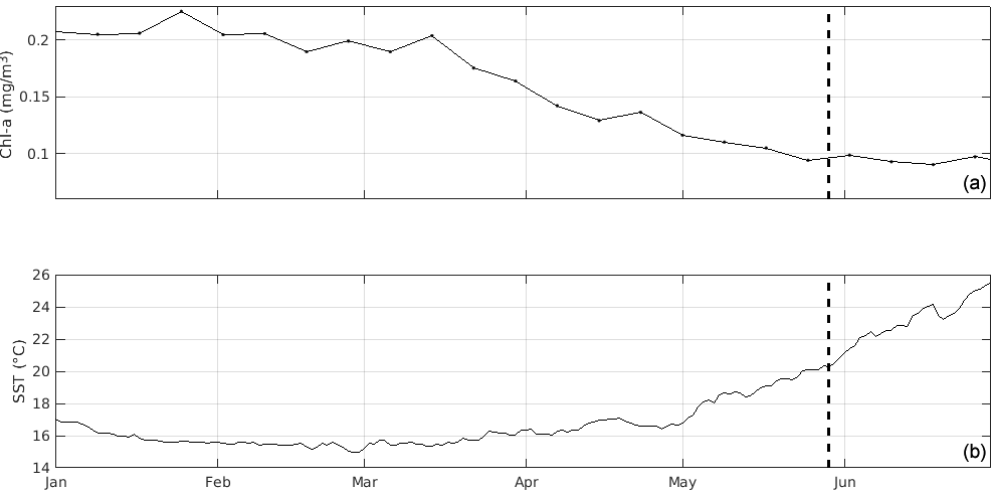
Figure 2. Time series of (a) 8d satellite chl a and (b) daily sea surface temperature (SST) prior to sampling, averaged over the northern Ionian Sea (34 to 40 ◦ N, 16 to 22 ◦ E). Sampling at ION-Tr is marked by the dashed vertical